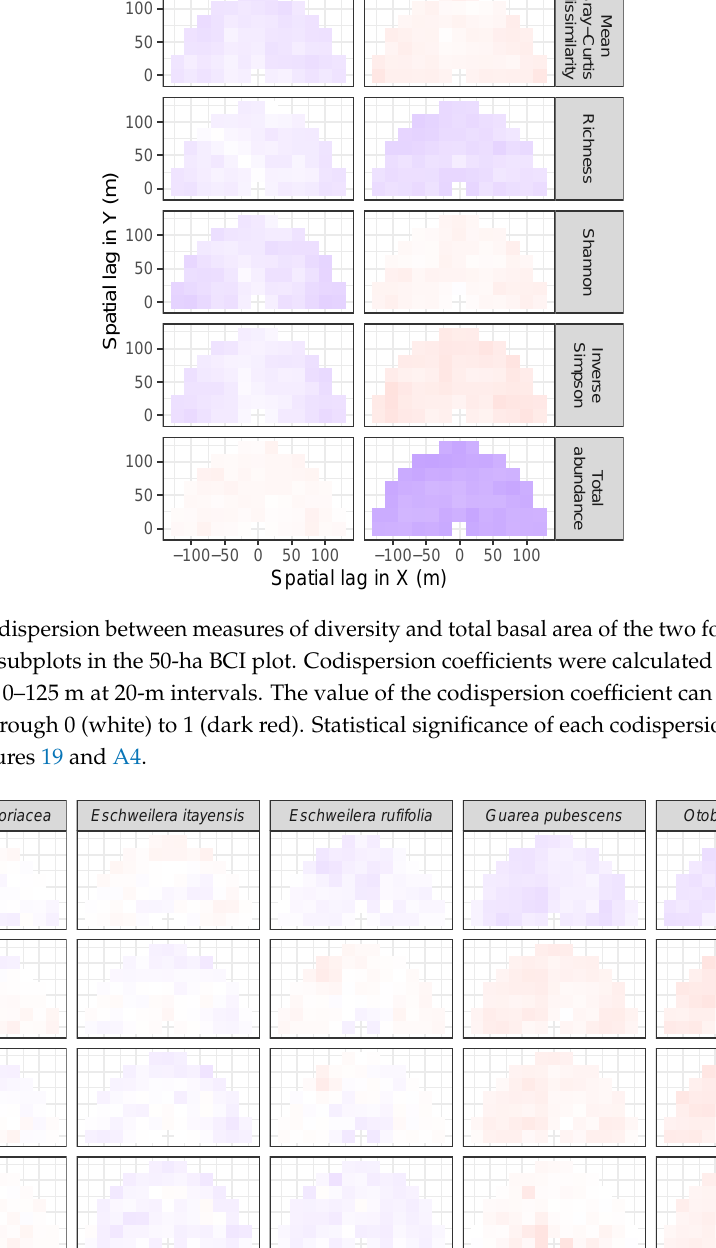
Figure 17. Codispersion between measures of diversity and total basal area of the five focal tree species in 20 20-m subplots in the 25-ha Amacayacu plot. Codispersion coefficients were calculated for × spatial lags ranging from 0–125 m at 20-m intervals. The value of the codispersion coefficient can range from 1 (dark blue) through 0 (white) to 1 (dark red). Statistical significance of each codispersion − coefficient is shown in Figures 20 and A5.